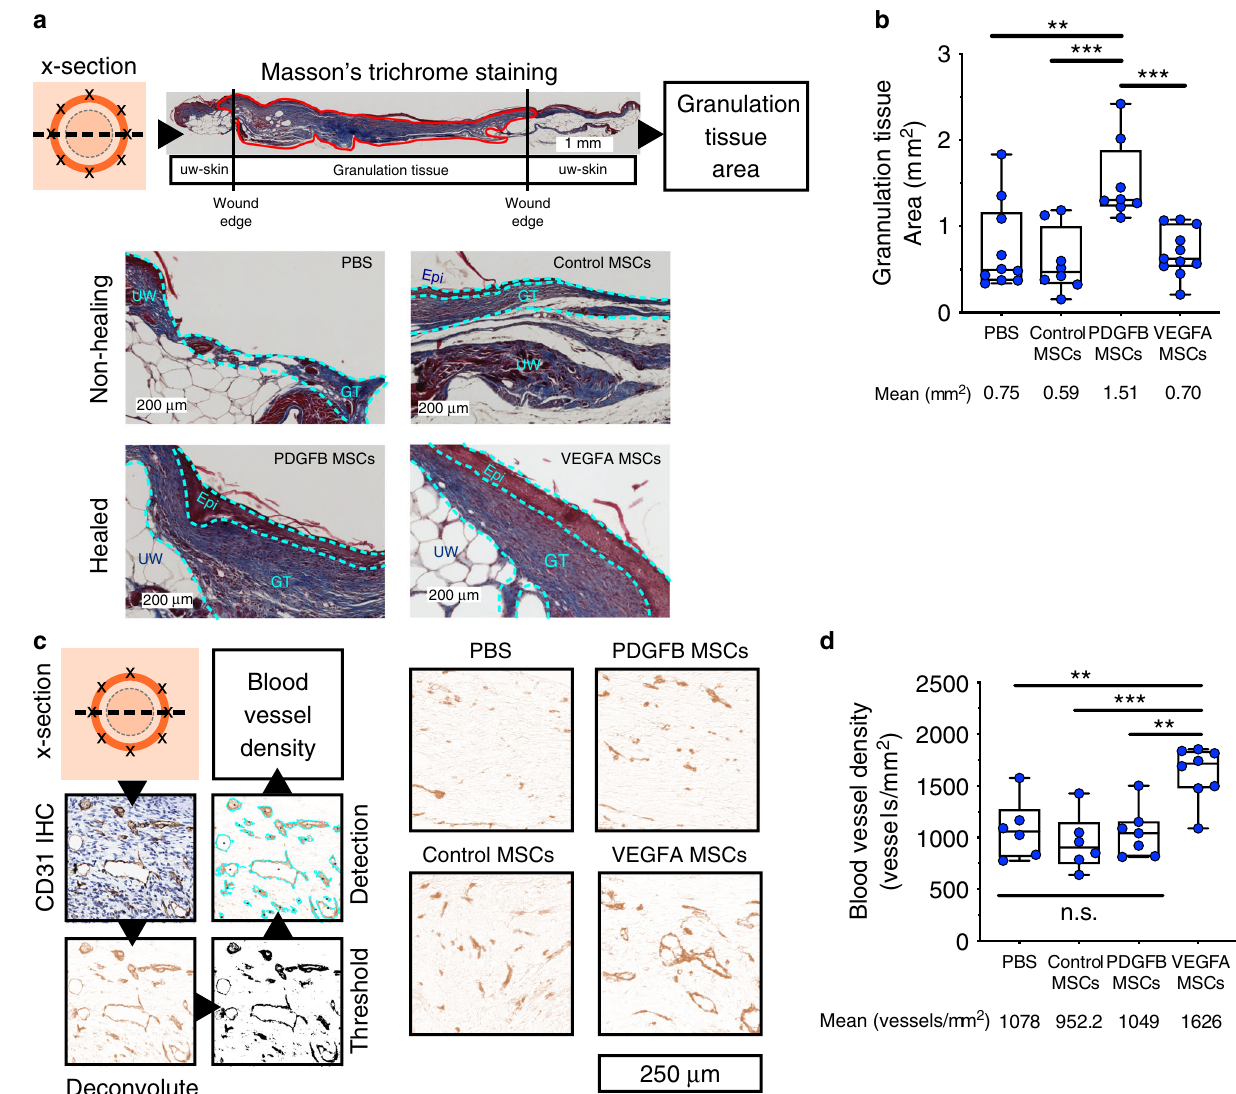
Fig. 5 Growth factor activities of PDGFB and VEGFA MSCs in fl uenced local changes in newly formed skin tissue. a Harvested tissues from 1-month-old wounds were cross-sectioned and stained with Masson ’ s trichrome dyes before light microscopy imaging. Amounts of granulation tissue were quanti fi ed as cross-section areas from high-resolution digital images. Representative images show impaired granulation tissue formation, which can be found in wounds from controls treatment groups, and mature granulation tissue in wounds from PDGFB MSC and VEGFA MSC treatment groups. Epi epithelium, GT granulation tissue, UW unwounded skin. b Box and whiskers plots show distributions of granulation tissue areas measured from cross-sections of individual wounds from PBS and hMSC controls, PDGFB MSC, and VEGFA MSC treatment groups ( n = 10, 8, 8, and 10 wounds, respectively). Minima and maxima are bounded by whiskers, lower bounds, centers, and upper bound of boxes represent the 25th, 50th, and 75th percentiles, respectively. Differences of means were tested by ordinary one-way ANOVA and p -values were computed using Tukey ’ s multiple comparisons test. Asterisks indicate p -values (* p < 0.05; ** p < 0.01, n.s.: p > 0.05). c (Left panel) Harvested tissues from one-month-old wounds were cross-sectioned (x-section) and stained with anti-mouse CD31 antibody. Stained blood vessels were detected from digital staining images using ImageJ software. Blood vessel density was calculated from whole granulation tissues. (Right panel) Representative blood vessel images from controls, PDGFB MSC, and VEGFA MSC treatment groups are shown. d Box and whiskers plots show distributions of blood vessel densities measured from cross-sections of individual wounds from PBS and hMSC controls, PDGFB MSC, and VEGFA MSC treatment groups ( n = 6, 6, 7, and 8 wounds, respectively). Minima and maxima are bounded by whiskers, lower bounds, centers, and upper bound of boxes represent the 25th, 50th, and 75th percentiles, respectively. Differences of means were indicated by ordinary one-way ANOVA and p -values were computed using Tukey ’ s multiple comparisons test. Asterisks indicate p -values (** p < 0.01; *** p < 0.001, n.s.: p > 0.05). Source data are available in the Source data fi